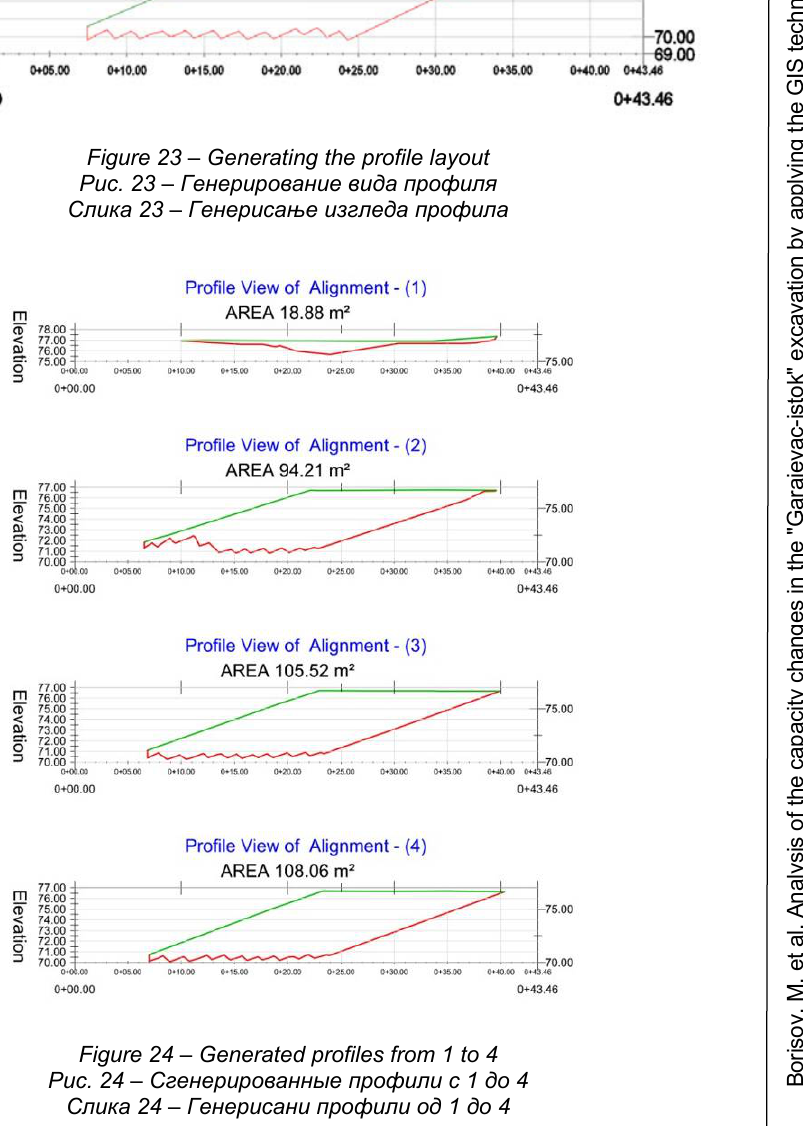
Figure 24 – Generated profiles from 1 to 4 Рис . 24 – Сгенерированные профили с 1 до 4 Слика 24 – Генерисани профили од 1 до